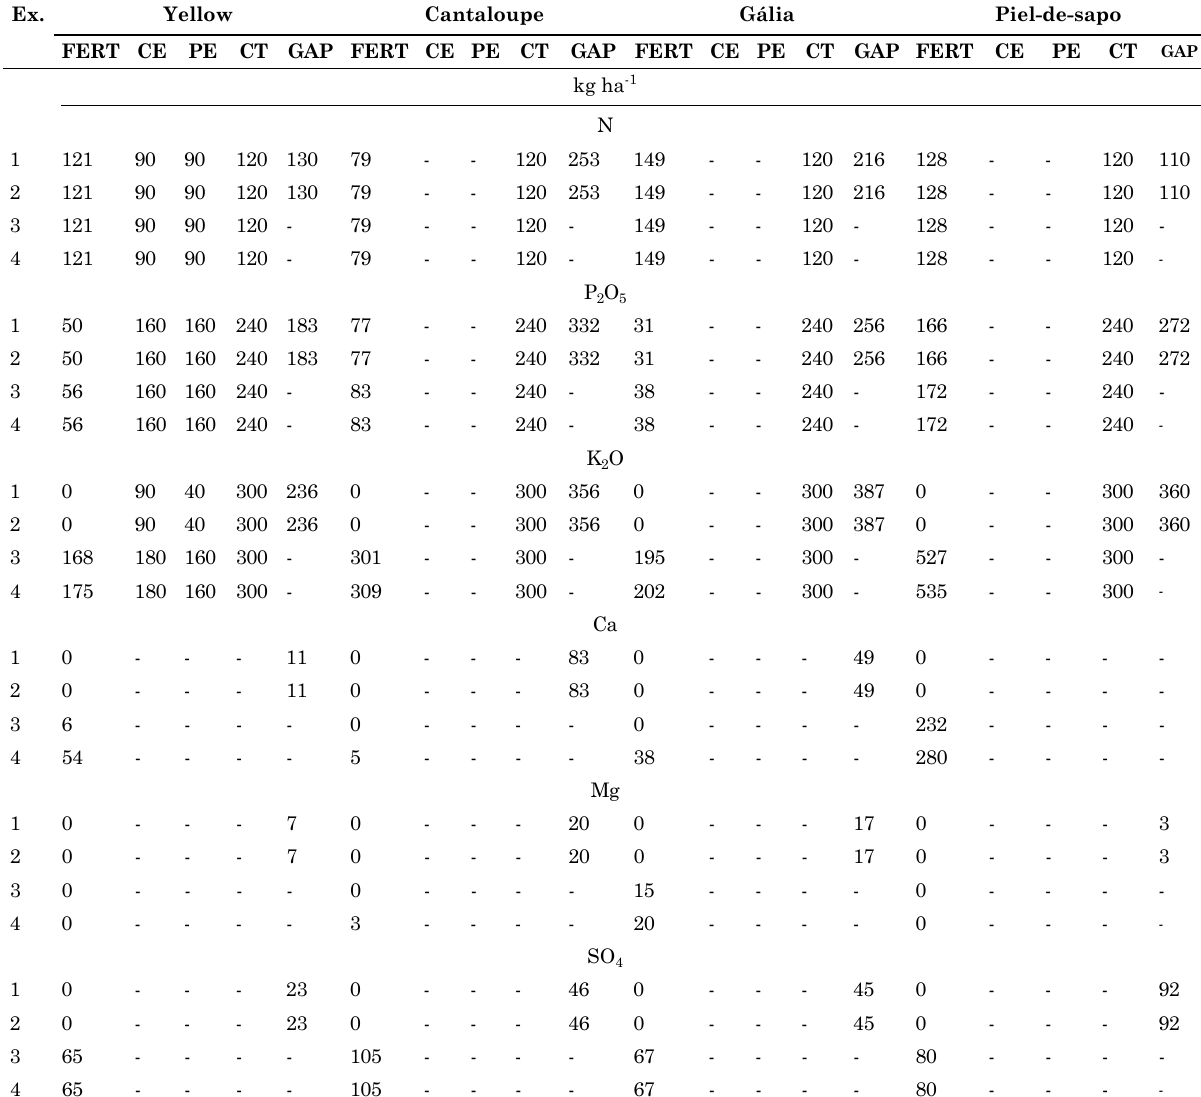
Table 11. Comparison of Ferticalc-melon nutrient recommendations with other methods currently used for fertilizer recommendation, considering a yield of 45 t ha -1